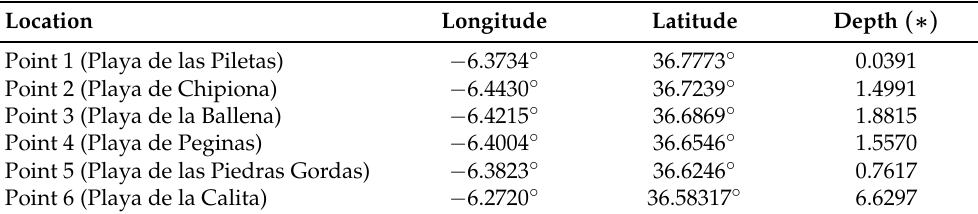
Figure A1. Location of the twelve forecast points considered for the 12-point NN models. Table A1. Geographical coordinates of the new locations used as forecasting points. (*) Depth values (in meters) refer to the numerical